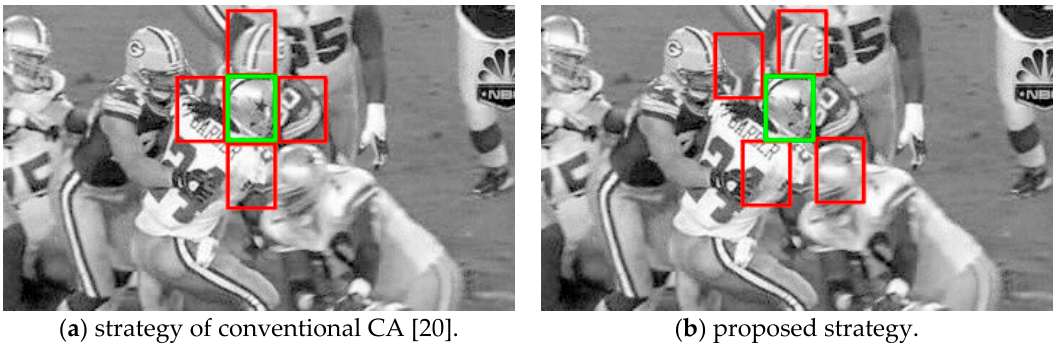
Figure 2. Two strategies of selecting context patches. The green rectangle denotes the target, and red rectangles denote selected context patches. rectangles denote selected context patches.